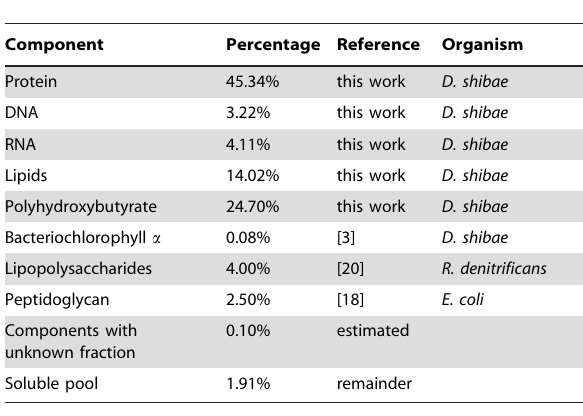
Table 1. Biomass composition used in the model i